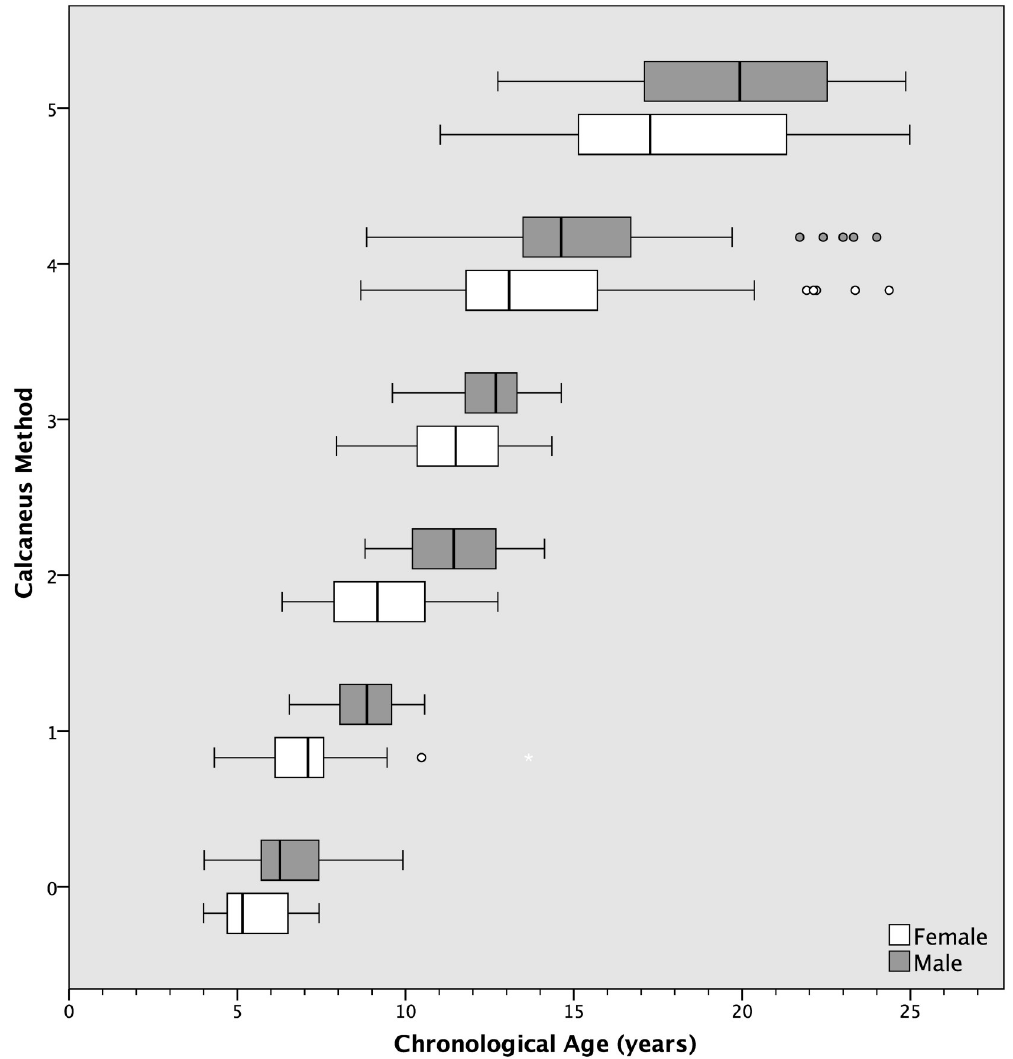
Fig 3. Distribution of chronological ages at each bone age stage with calcaneus method. Gender is shown at each stage.